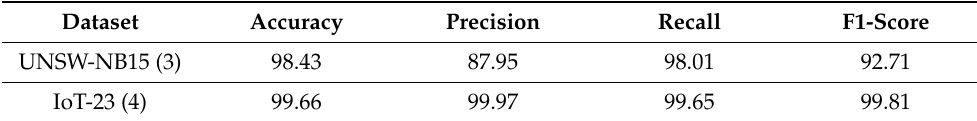
Table 9. The inference results (in %) for the two trained models on the PYNQ-Z2 board. Dataset Accuracy Precision